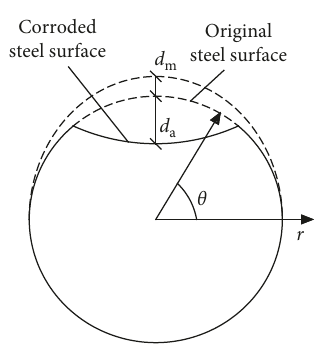
Figure 7: The reverse semi-elliptic model.